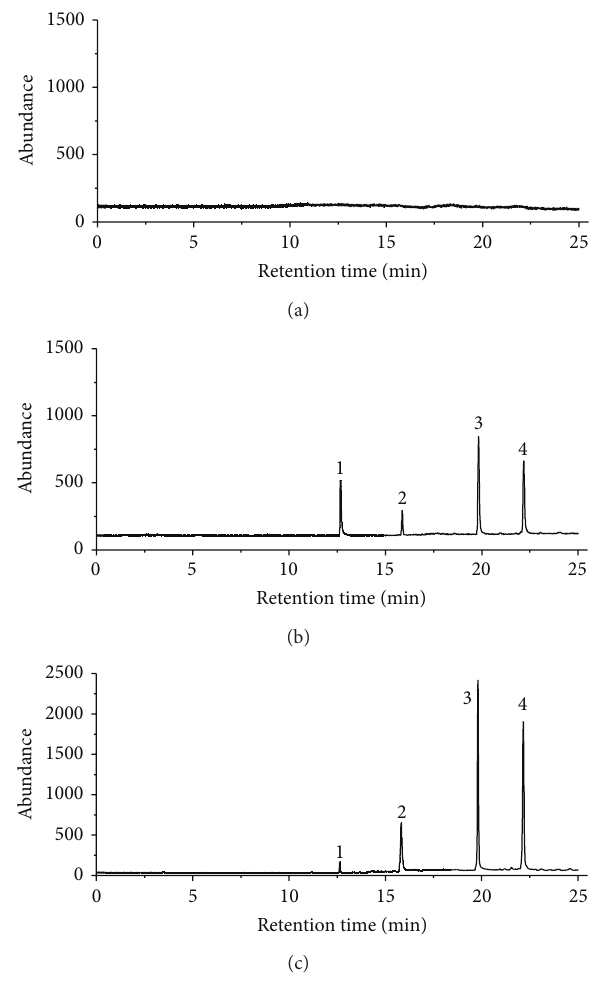
Figure1:GC-MS/SIMchromatograms:(a)ratblankplasmasample; (b) standard solutions of methyl eugenol (0.2 𝜇 g/mL), 𝛽 -asarone (0.2 𝜇 g/mL), 𝛼 -asarone (0.2 𝜇 g/mL), and IS (0.1 𝜇 g/mL); (c) rat